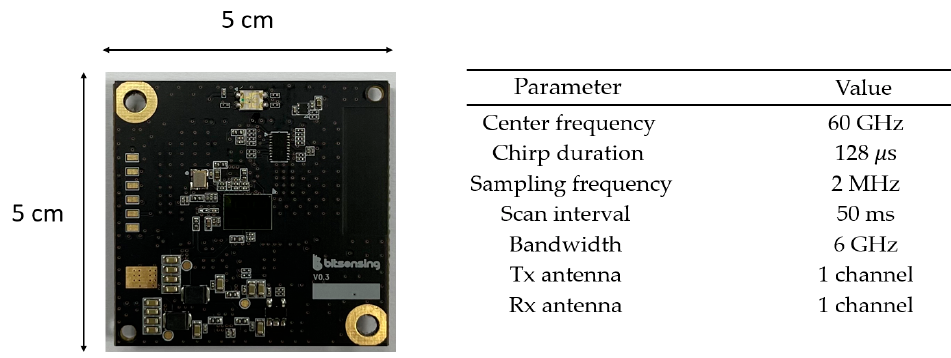
Figure 6. Single-channel FMCW radar.